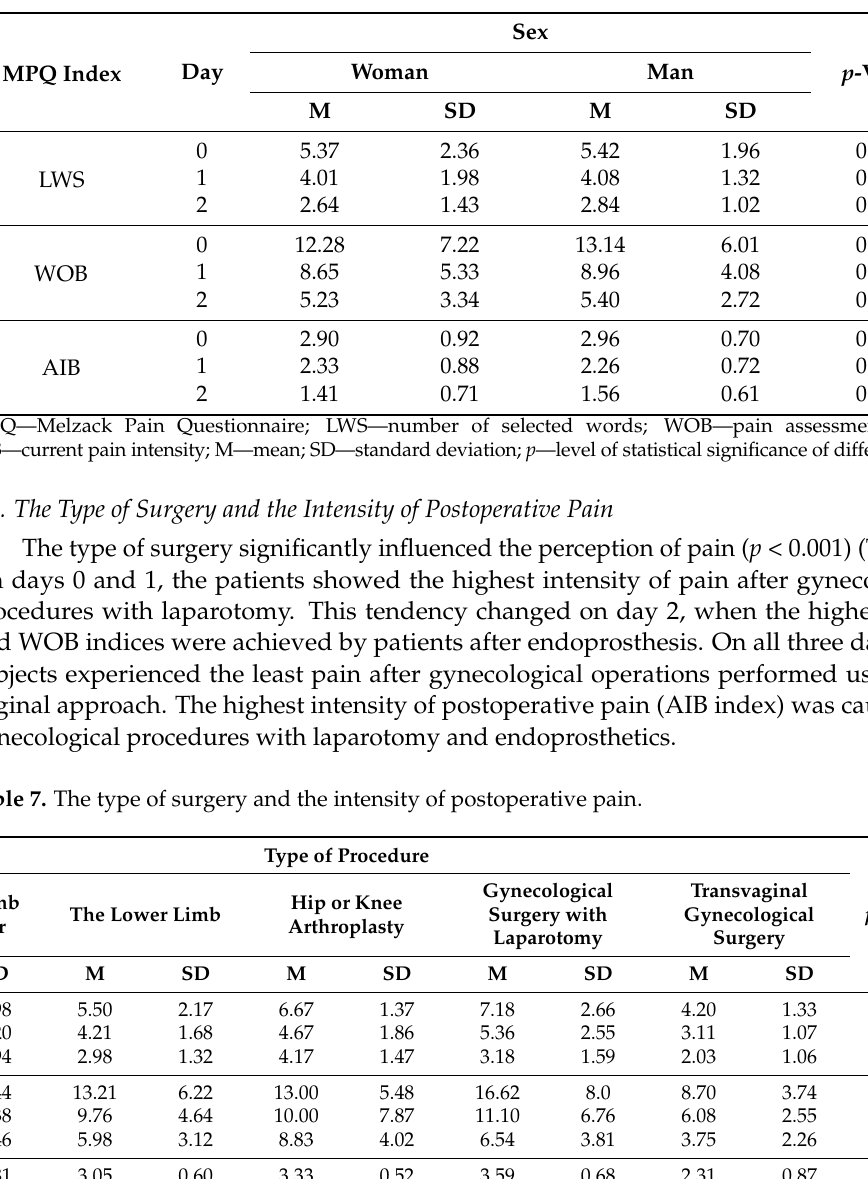
Table 6. Pain ailments and the sex of patients.